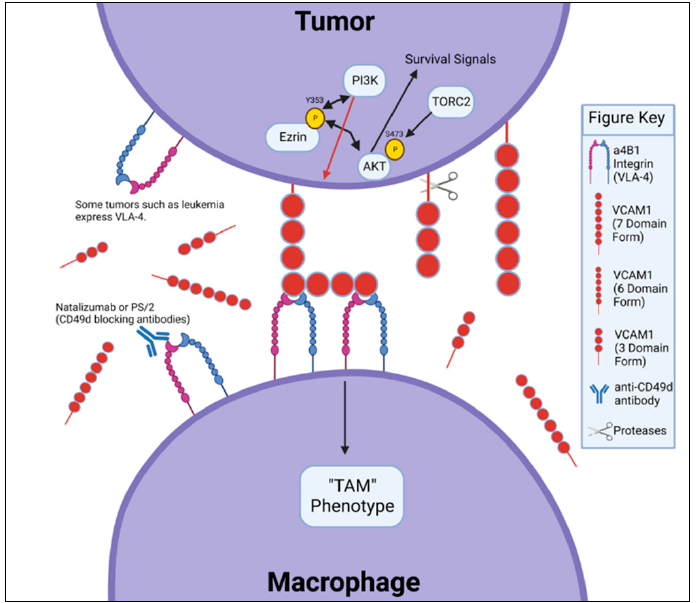
Figure 2. Signaling crosstalk between isoforms of VCAM-1 on tumor surface and VLA4 on macrophages. VLA-4 is also expressed on certain tumors to facilitate metastasis and therapy resistance.